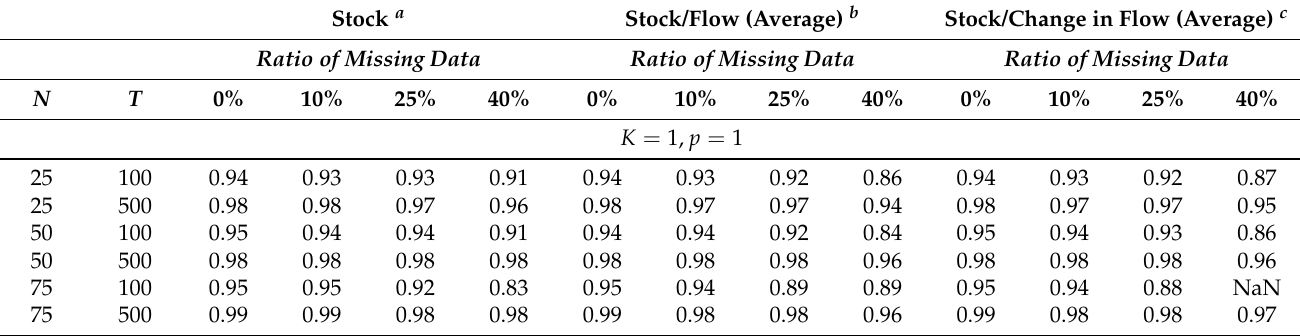
Table A1. Means of trace R 2 for random ADFMs using standard KF and